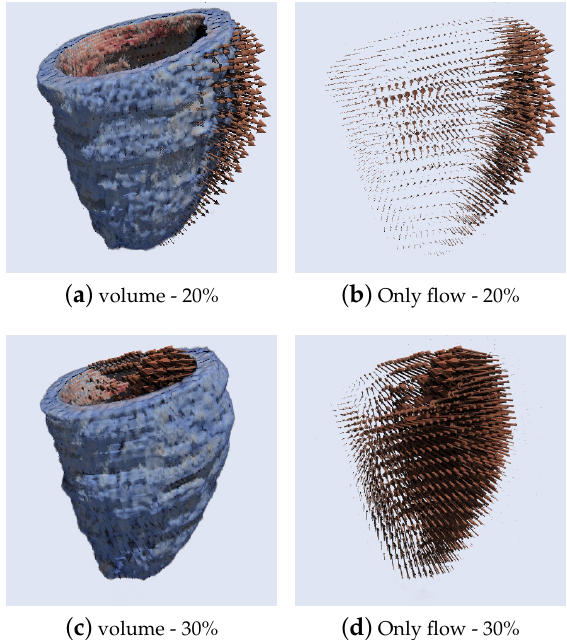
Figure 21. Results of 3D Optical Flow of a segmented cardiac CT volume (left ventricle) computed at phases 20–30% (contraction movement).